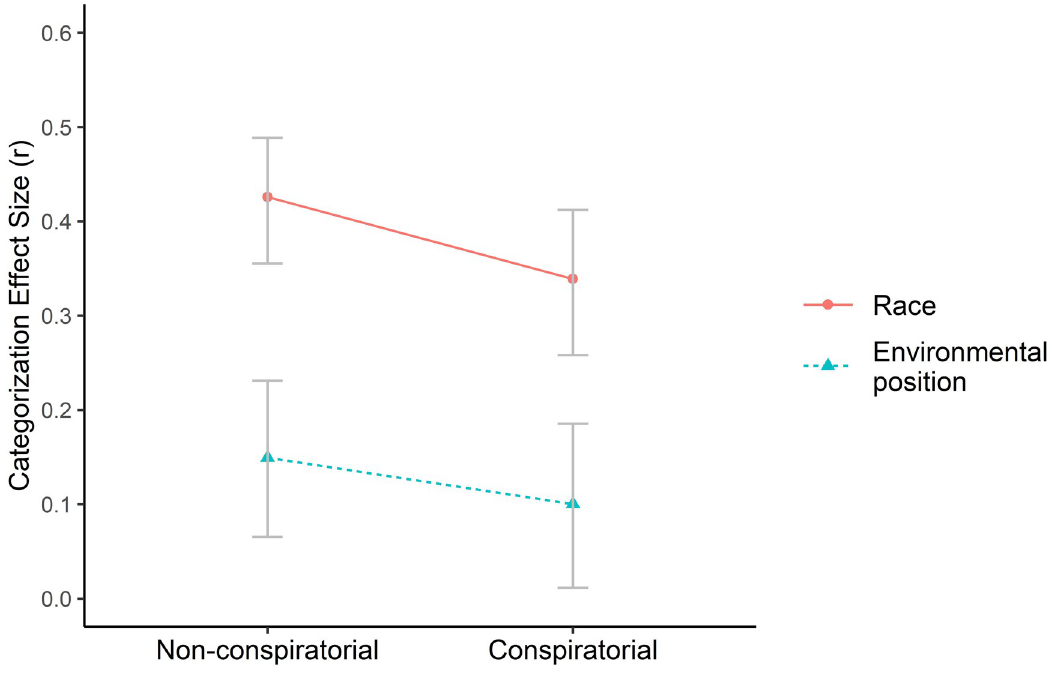
Fig 2. Categorization by race and environmental position when statements are framed either in a non-conspiratorial (control) or conspiratorial (treatment) form (N = 1147). Only race categorization was significantly lowered by the use of a conspiratorial frame. The reported numbers are effect sizes (r). Error bars correspond to bootstrapped 95% confidence intervals.